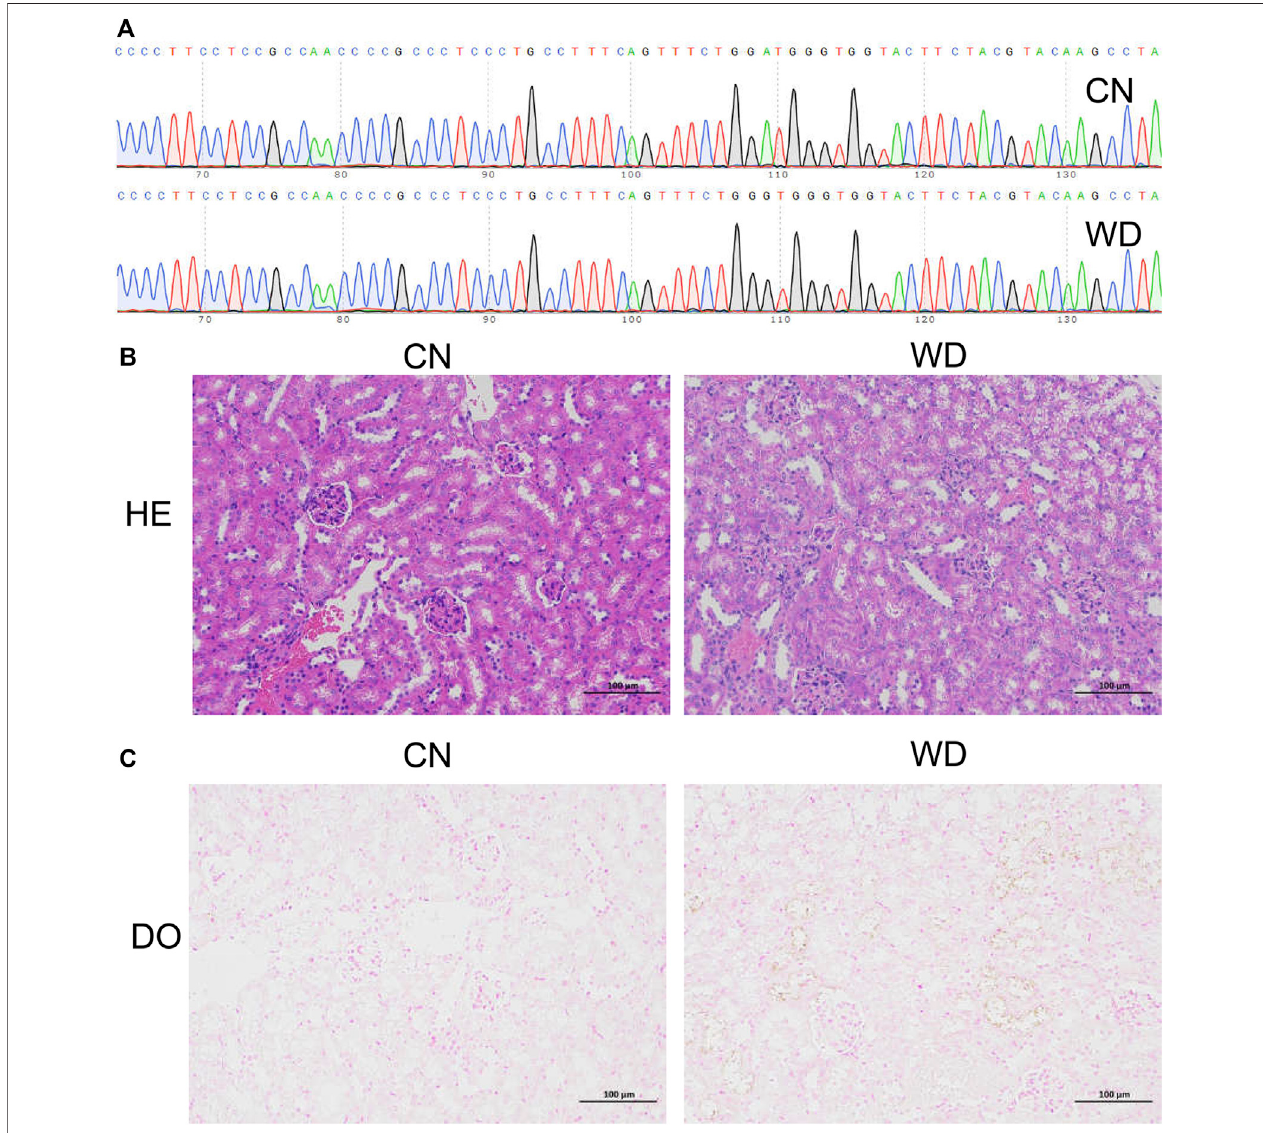
FIGURE1| Con fi rmation oftheWDTX-Jmouse modelwithkidneyinjury. (A) Sangersequencing oftheTX-Jmodelmice (diploidmutationtype, Modelgroup) and controlmice(diploidwildtype,CNgroup). (B) HEand (C) DOpathologicalstainingofkidneysinModelandCNgroups.HE,Haematoxylinandeosin;DO,Dithiooxamide.